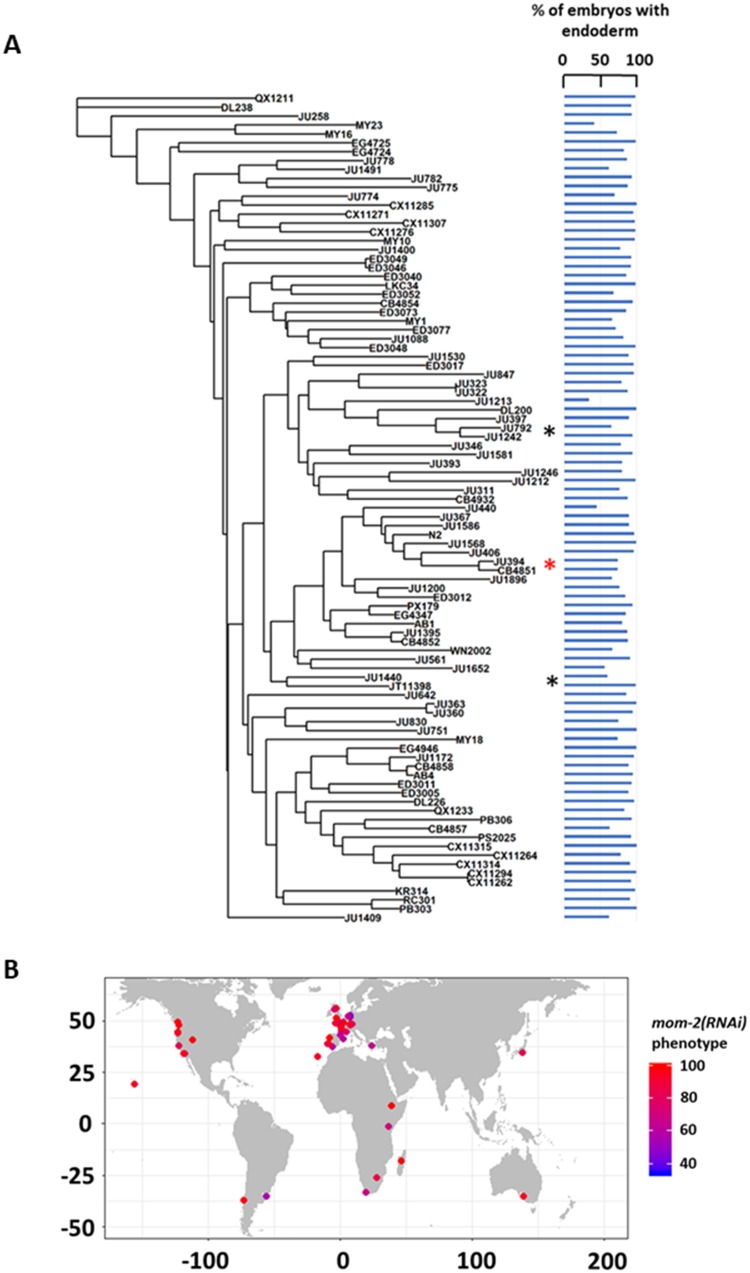
MOM-2 requirement does not correlate with genotypic relatedness or geographical location.(A) mom-2(RNAi) phenotype of 94 isolates arranged with respect to the neighbor-joining tree constructed using 4,690 SNPs and pseudo-rooted to QX1211. Red asterisk indicates an example of closely related strains (JU394 and CB4851) with similar phenotypes, while black asterisks indicate examples sister strains (JU792 and JU1242; JU1440 and JT11398) with distinct phenotypes (λ = 6.94×10^−05, p-value=1). (B) Worldwide distribution of mom-2(RNAi) phenotype across 94 isolates. Each circle represents a single isolate.